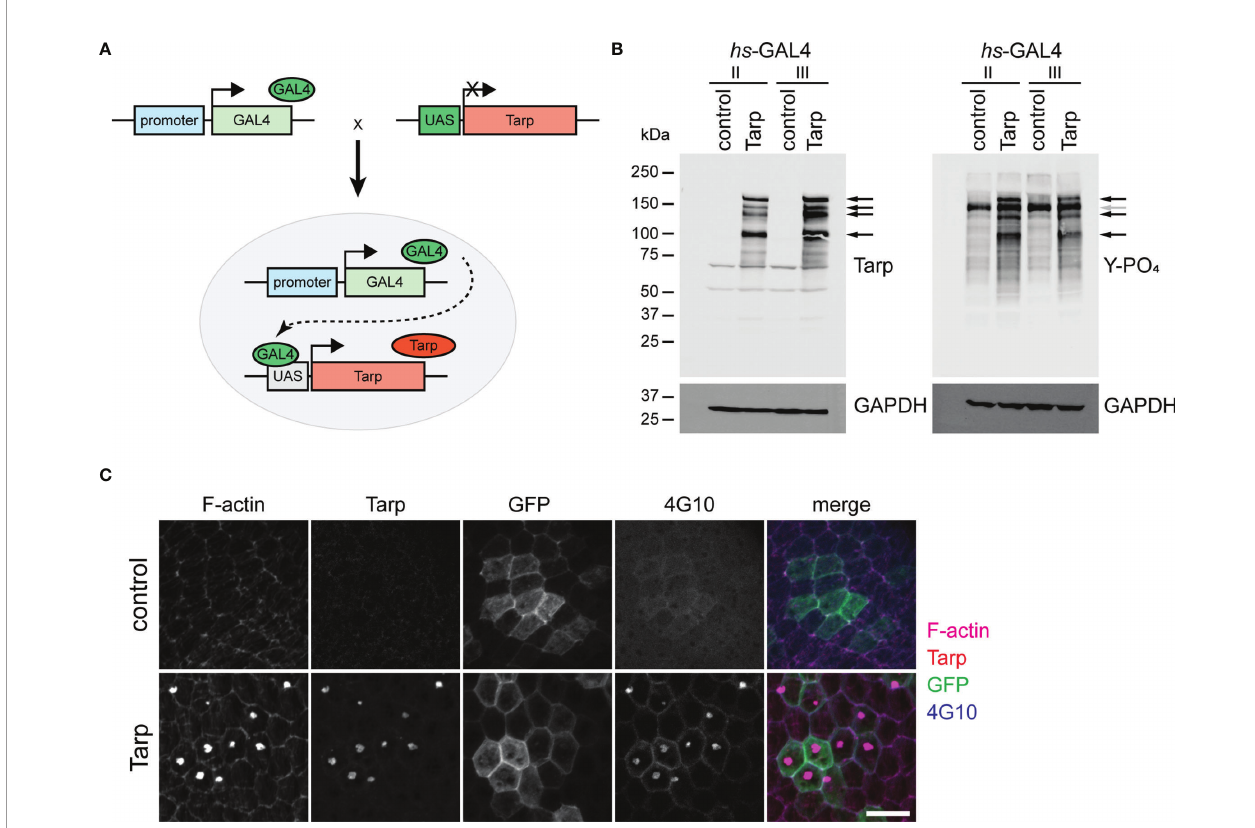
FIGURE 1 | Transgenically expressed Tarp is phosphorylated and forms actin-rich aggregates in fl ies. (A) Schematic diagram of the GAL4/UAS binary expression system. A transgenic fl y stock was created, containing the Tarp open reading frame downstream of the UAS promoter. The Tarp transgenic fl y is crossed with another fl y that encodes for the GAL4 transcription factor with a de fi ned expression pattern. The progeny of the cross combines both components, prompting Tarp expression in cells where GAL4 is expressed. (B) Western blots showing Tarp expression and corresponding tyrosine phosphorylation in fl ies. Black arrows indicate Tarp bands. Gray arrow indicates the location of a Tarp band obscured by endogenous phosphotyrosine signal. hs-GAL4/UAS-Tarp fl ies were heat-shocked at 37°C for 1 hour. hs-GAL4/+ fl ies were used as control. Whole fl y lysates were analyzed for the expression of Tarp (left) and tyrosine phosphorylation (right). Two unique hs-GAL4 lines were used (II and III). GAPDH was used as loading control. (C) Tarp localizes to actin-rich aggregates in epithelial cells. Clonal populations of follicle epithelial cells (see Immunostaining methods) were immunostained for Tarp, F-actin, and tyrosine phosphorylation (4G10). GFP identi fi es cells in which GAL4/ UAS expression is active. Scale bar,10 m